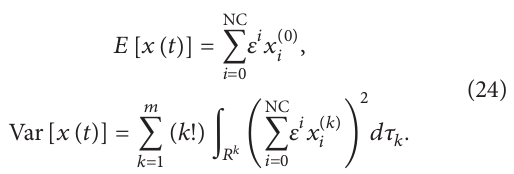
These results are consistent with the known results obtained using WHE. In WHE, higher-order kernels are driven by lower-order kernels, and at the bottom, the Gaussian kernels are driven by the random forcing directly. So, the lower-order kernels are usually dominant in magni- tude